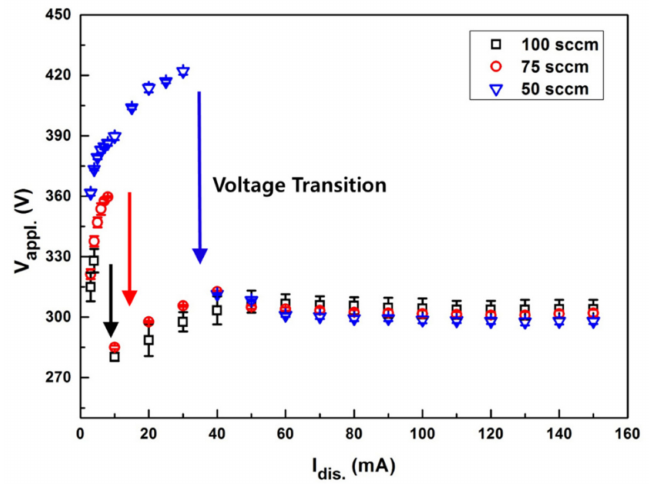
Figure 4. VI characteristics (applied voltage vs. discharge current) of the developed plasma source with various gas flow rates.